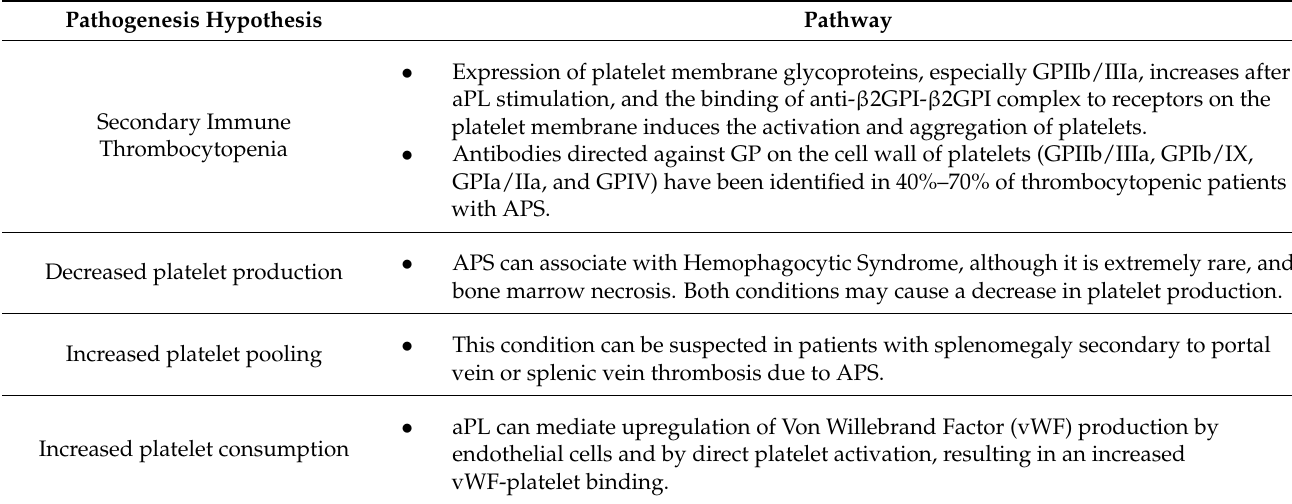
Table 2. Pathogenetic mechanisms involved in thrombocytopenia within the context of